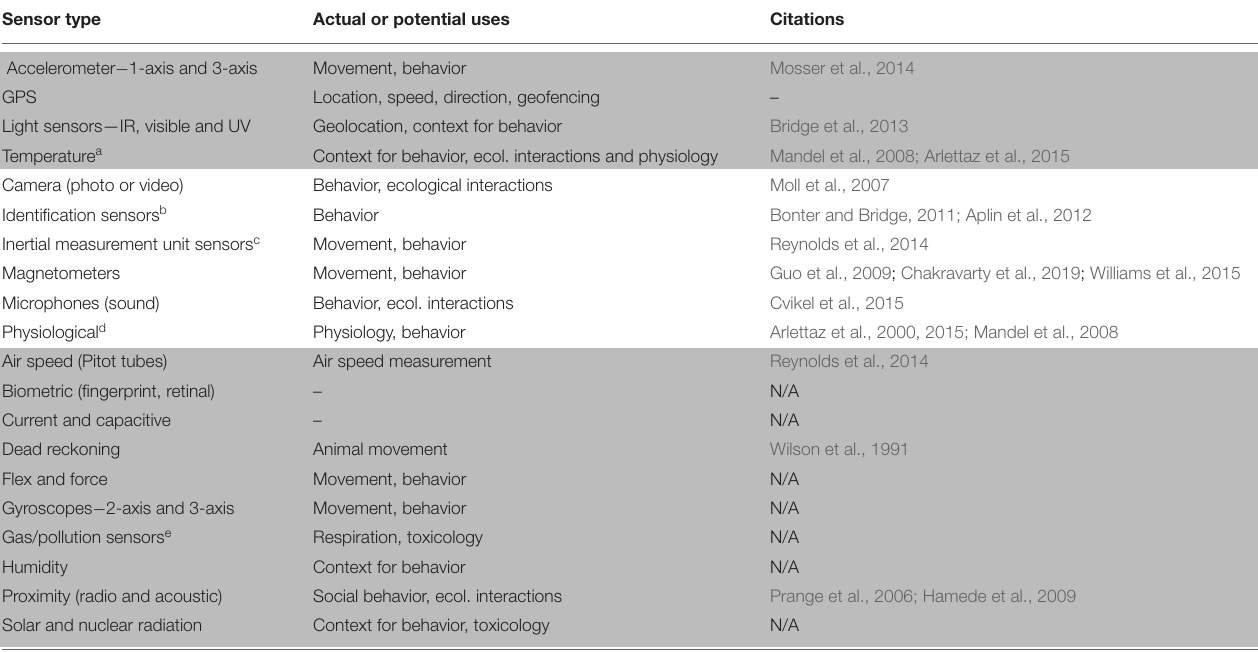
TABLE 1 | Types of sensors available from commercial manufacturers that have been or that could be integrated into on-board animal bio-logging devices in terrestrial systems. Sensor